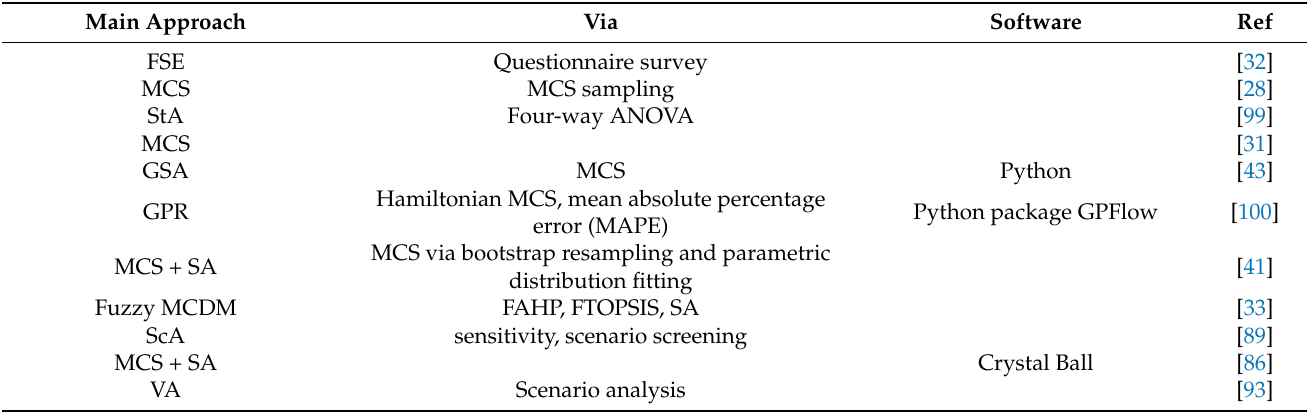
Table 6. Uncertainty analysis methods and tools in the selected